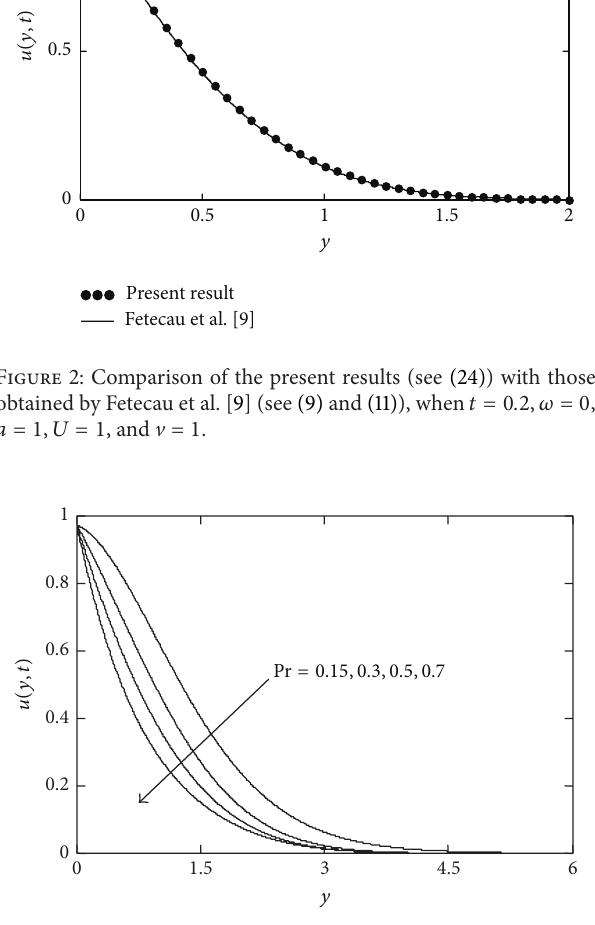
Figure 3: Profiles of velocity for different values of Pr, when 𝜔 = 𝜋/4 , 𝑡 = 0.2 , and Gr = 3 .